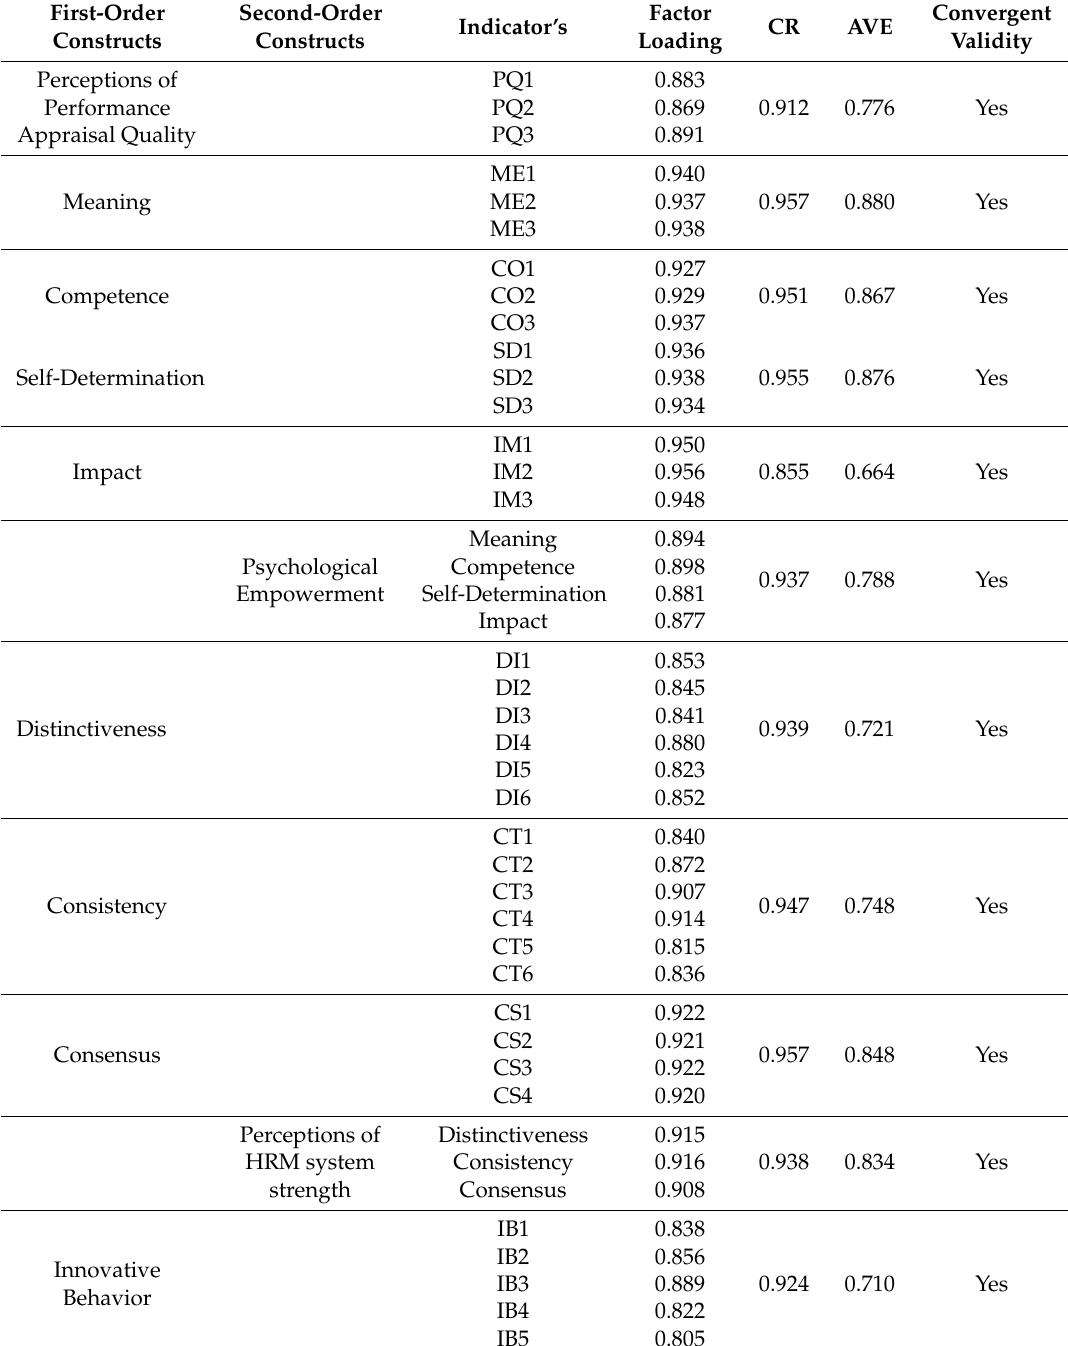
Table 1. Results of the measurement